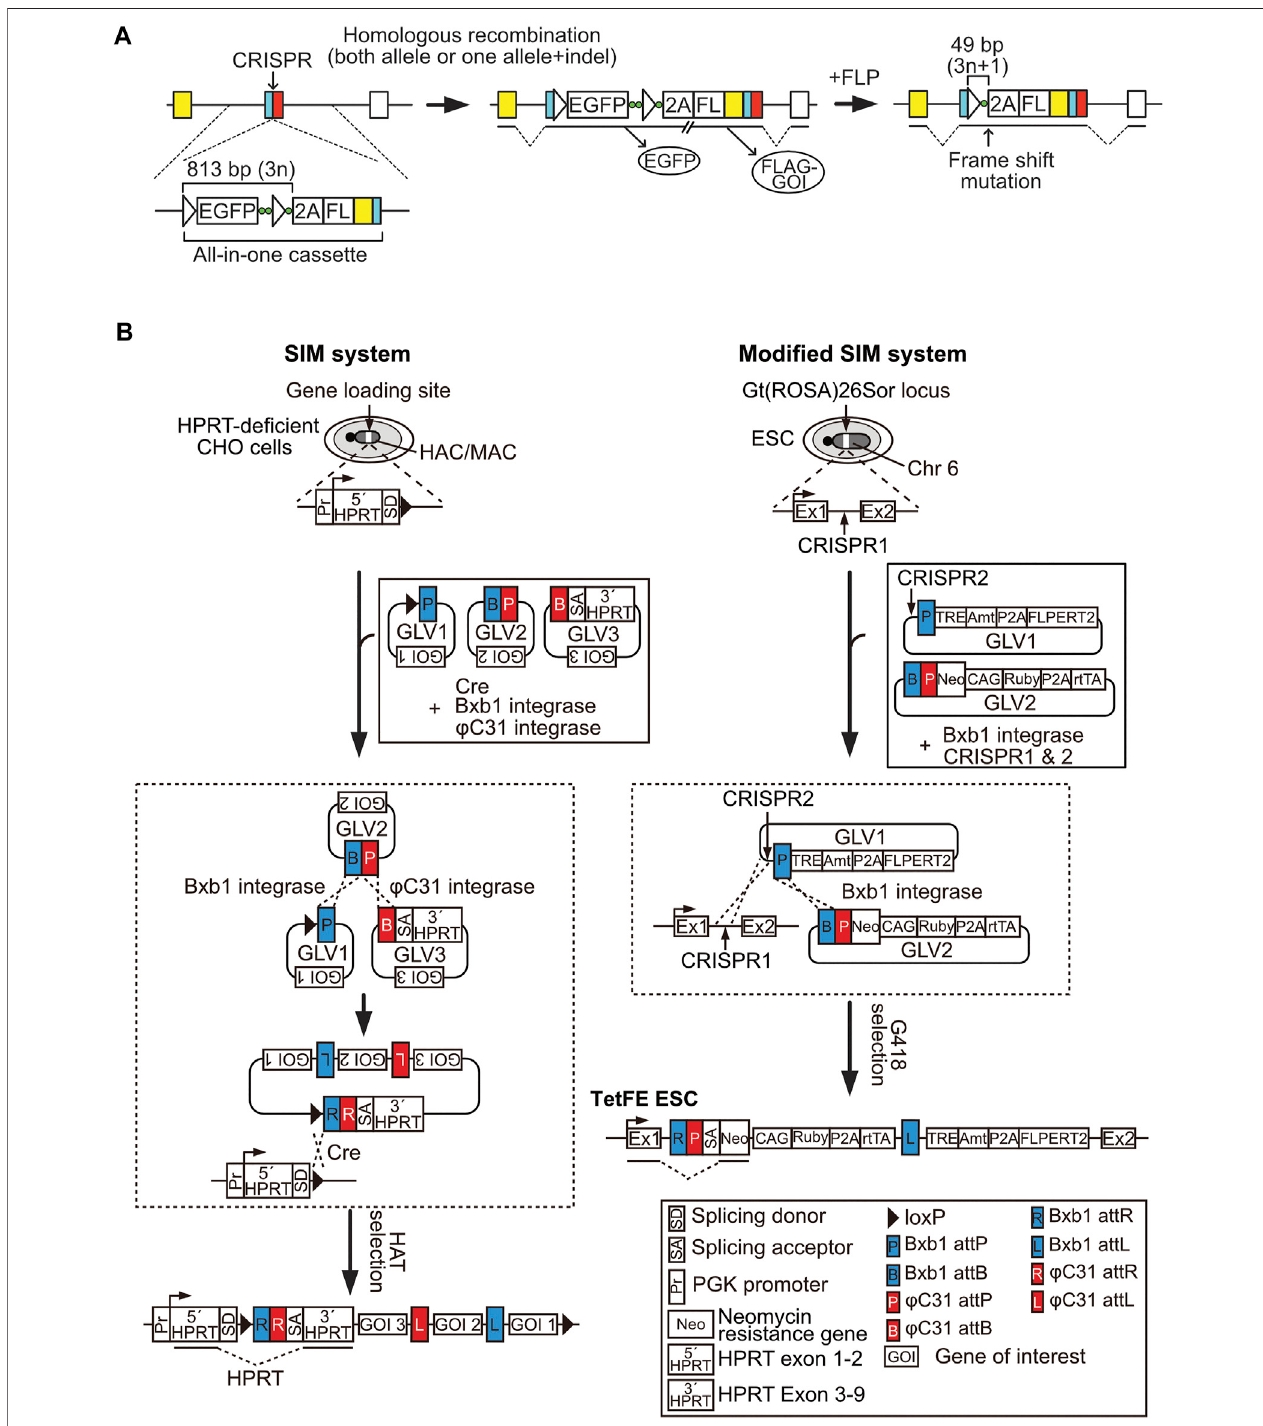
FIGURE 2 | The simultaneous or sequential integration of multiple genes (SIM) system and all-in-one conditional knockout (cKO) methods. (A) All-in-one cKO method. Green circle, nucleotides used to induce a frame-shift mutation; empty triangle, FRT site; FL, 3 × FLAG-tag sequence. (B) Schematic representation of the SIM system and the modi fi ed SIM system. The SIM system and the modi fi ed SIM system enable simultaneous loading of multiple gene loading vectors (GLVs) into a human arti fi cial chromosome/mouse arti fi cial chromosome vector and a safe harbor locus, respectively. The procedure to generate TetFE ESCs is shown as an example for loading multiple GLVs via the modi fi ed SIM